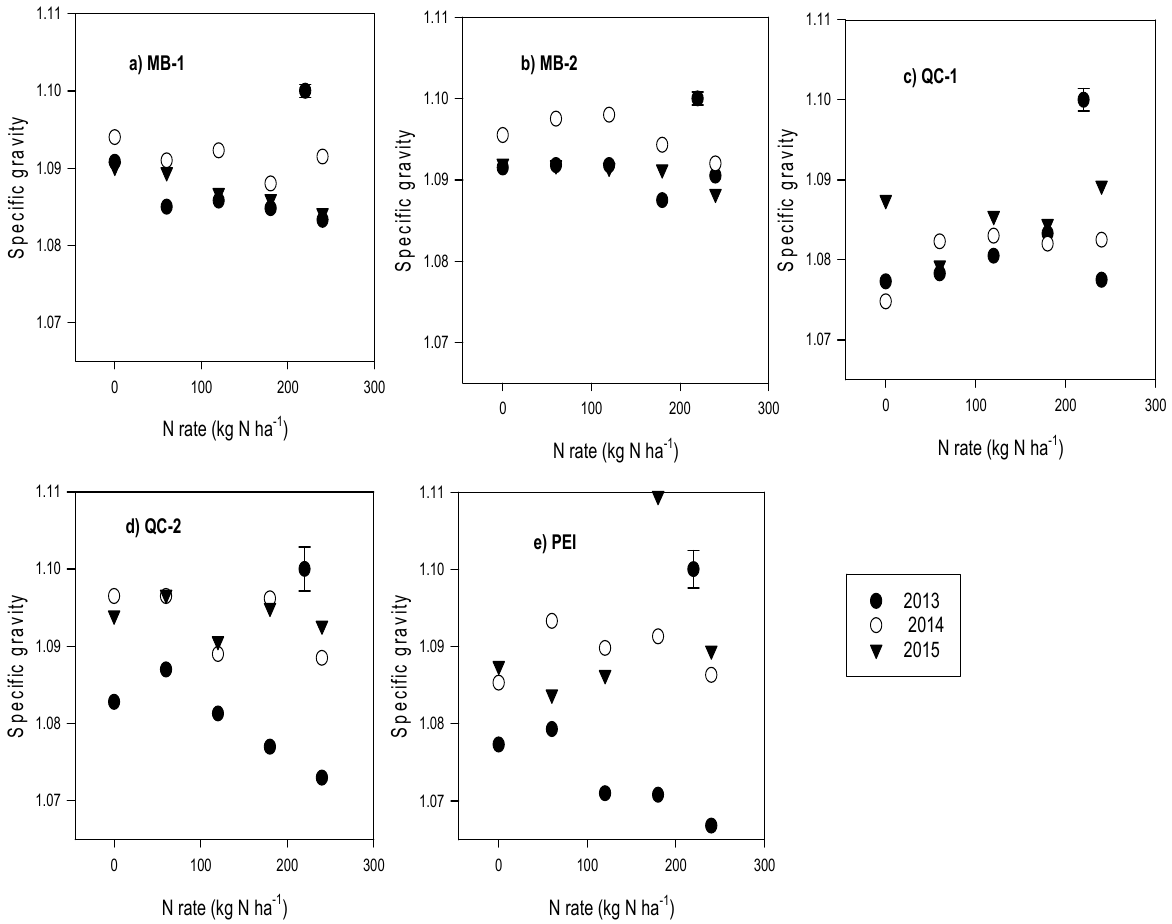
Figure 3. Specific gravity versus N rate at: MB-1 ( a ), MB-2 ( b ), QC-1 ( c ), QC-2 ( d ) and PEI ( e ) in 2013, 2014, and 2015. Vertical bars represent the standard errors of the